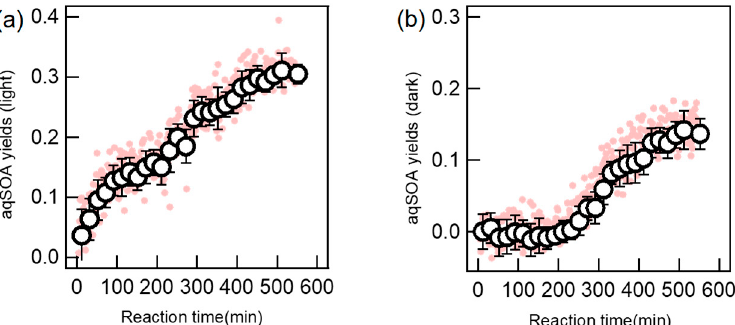
Figure 2. Mass yields of the aqSOA formed during hydroxyl radical (OH)-mediated photochemical oxidation ( a ) and dark oxidation ( b ) (note in each plot, the first pink point is zero; the first black circle is the average of the first 7 pink points, namely the 10.5 min average value; other black circles are average values of every 12 pink points, namely the 18 min average; the error bar is one standard deviation).